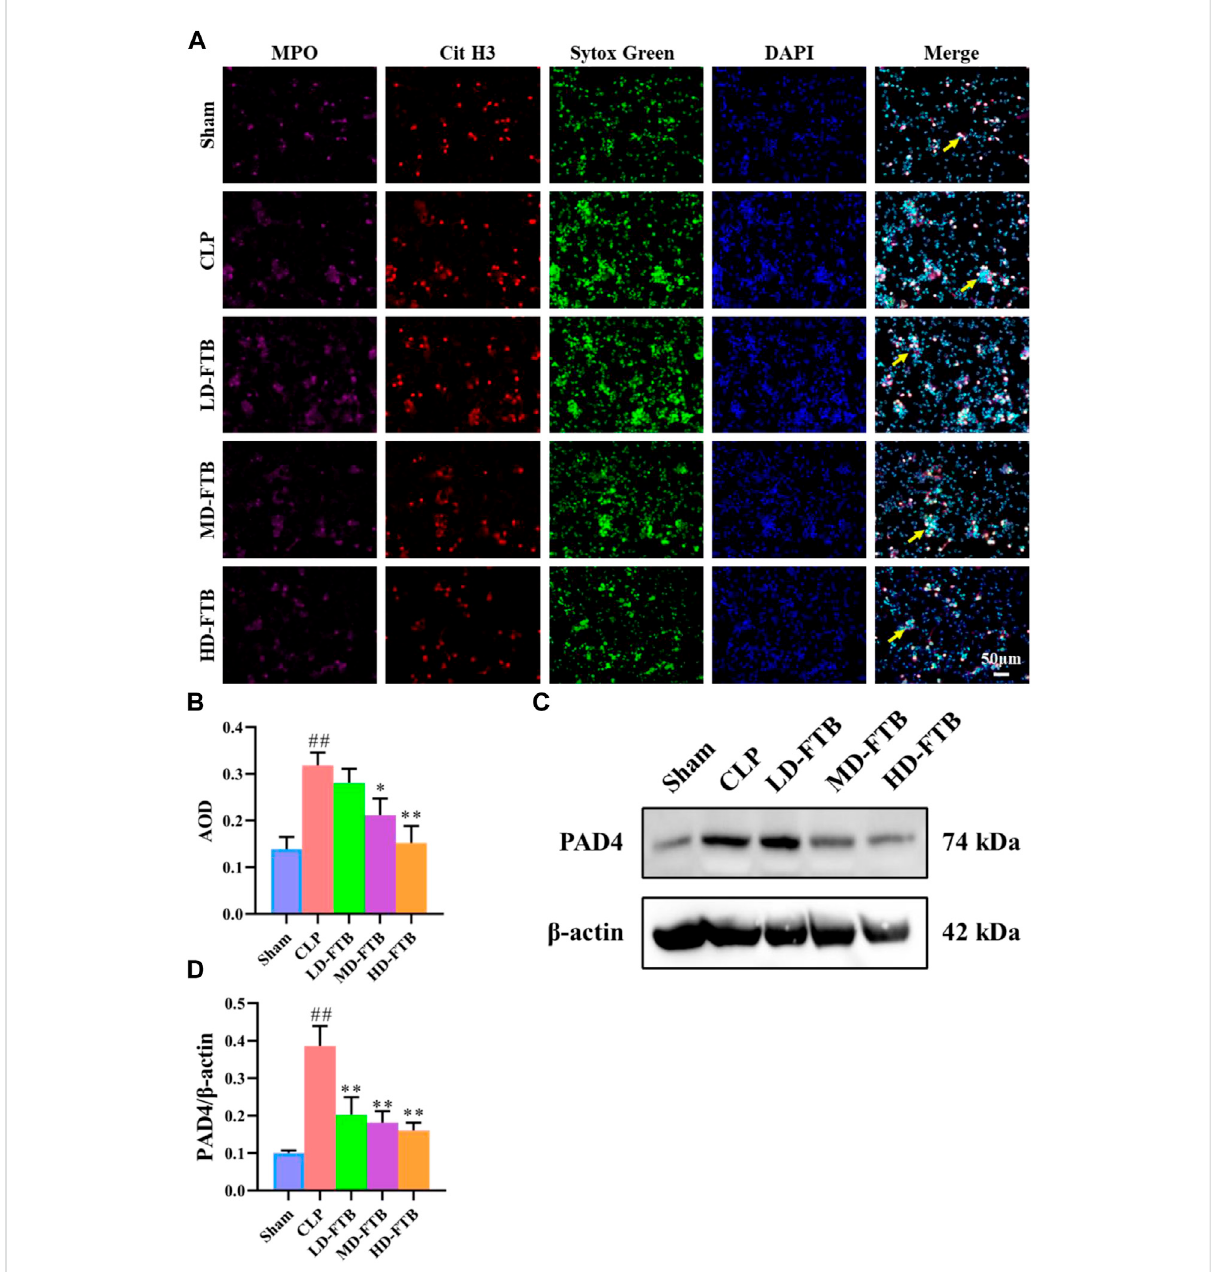
FIGURE 5 Effects of FTB on NETs formation and PAD4 expression in neutrophils isolated from the peripheral blood of rats with sepsis. The NETs were induced by exposure to phorbol-12-myristate-13-acetate (PMA) (100 mM) for 3 h. The formation of NETs was observed by investigating the expression of myloperoxidase (MPO), citrullinated histone H3 (Cit H3), and Sytox green in cells using immuno fl uorescence (yellow arrows indicate the positive expression of NETs) (A) and the positive expression area was quanti fi ed based on AOD (B) . The protein expression of PAD4 in neutrophils was measured using Western blot, β -actin was used as a loading control (C) . The relative expression of PAD4 was quanti fi ed based on the gray values (D) . FTB treatment inhibited the NET formation and decreased the PAD4 expression in